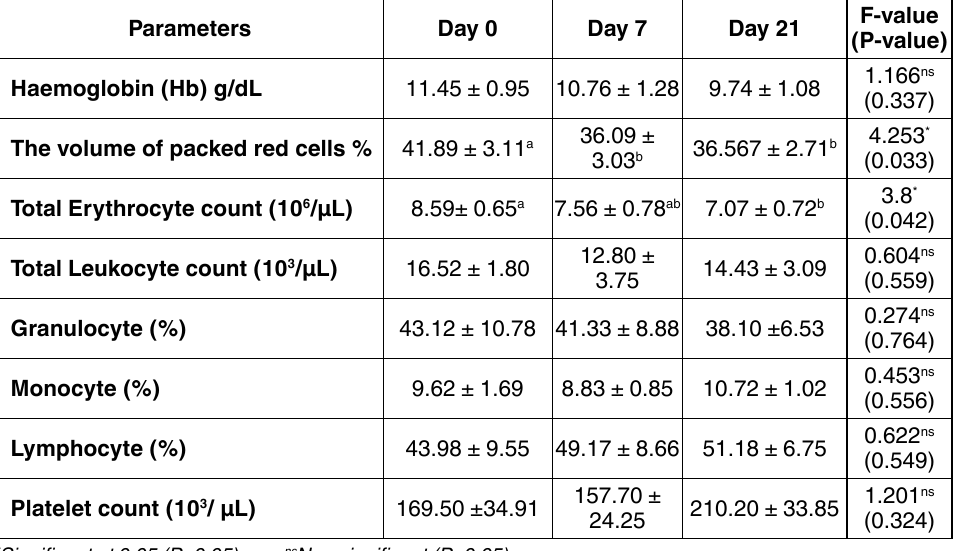
table 3. Observations on haematological parameters (Mean ± SE) in tom cats